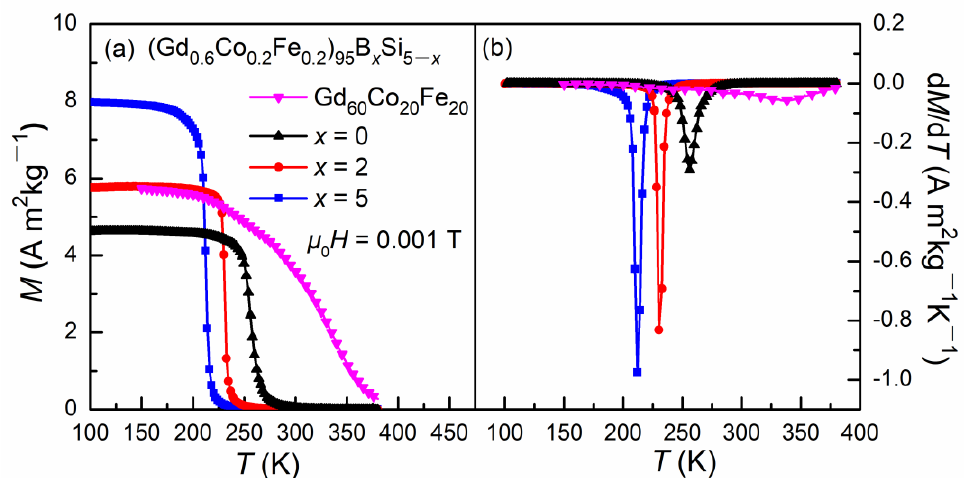
Figure 2. M – T curves of the Gd 60 Co 20 Fe 20 and (Gd 0.6 Co 0.2 Fe 0.2 ) 95 B x Si 5 − x ( x = 0, 2, 5) amorphous alloys under an applied magnetic field of ( a ) 0.001 T and ( b ) the correlating curves of d M /d T vs. T